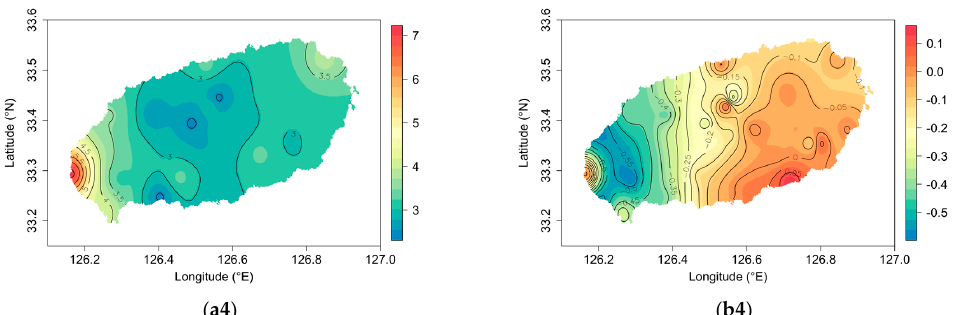
Figure 4. Spatial distribution of ( a ) annual average monthly meteorological values of the extended data (EXT) and ( b ) the difference between extended and observed data (EXT-OBS). ( a1 ) T max (EXT) in °C; ( a2 ) T min (EXT) in °C; ( a3 ) RH (EXT) in %; ( a4 ) WS (EXT) in m/s; ( b1 ) T max (EXT-OBS) in °C; ( b2 ) T min